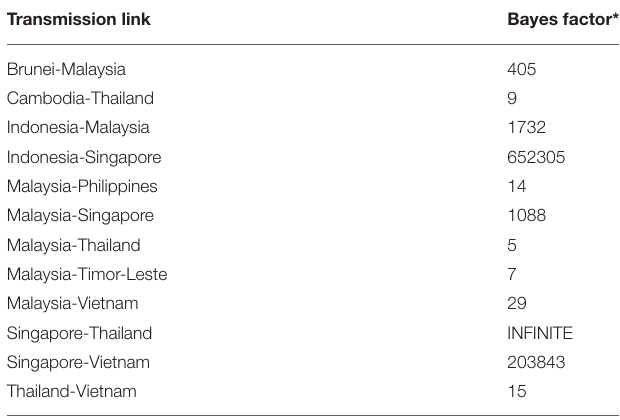
TABLE 1 | Two-way Bayes factor tests for SARS-CoV-2 transmission links in Southeast